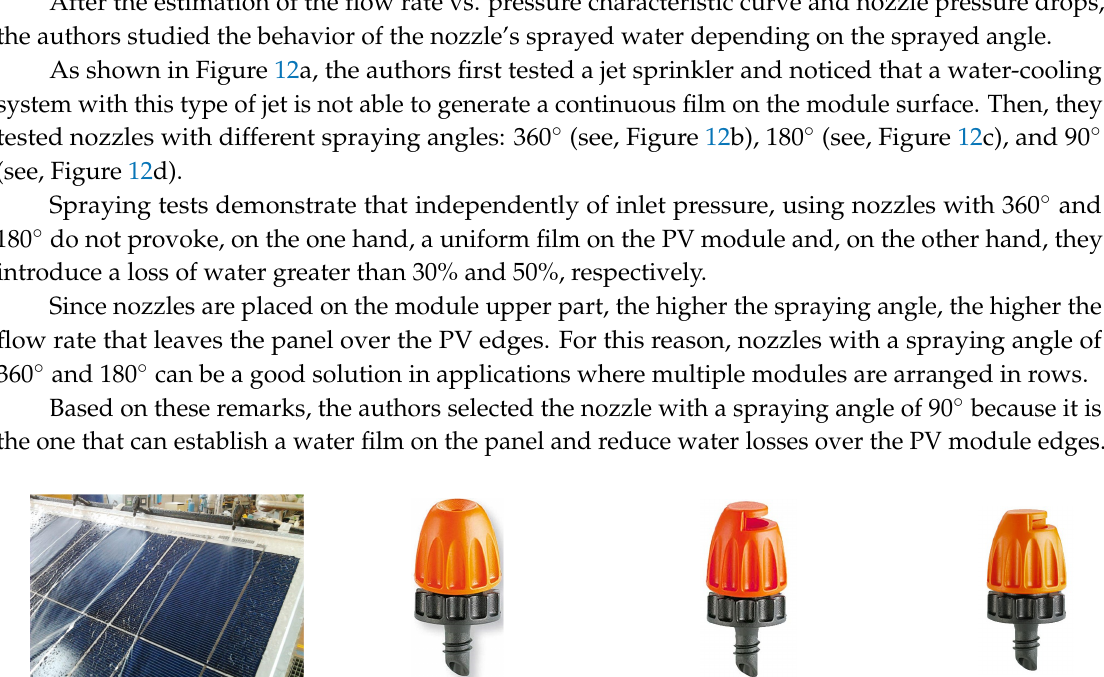
( c ) Figure 13. Spraying test with ( a ) 2 water nozzles, ( b ) 6 water nozzles, ( c ) 9 water nozzles. Further to previous points, it is worth remarking that 3 nozzles sprayed water at a pressure of 0.25 bar discharge 61 L/h while with an inlet pressure of 2.0 bar, water consumption becomes approximately 162 L/h. Given that the cooling system operates for at least 6 h per day during summer time, water consumptions per single PV module ranges between 368 L/day and 972 L/day. These values are unacceptable. For this reason, the authors developed a management strategy in which the